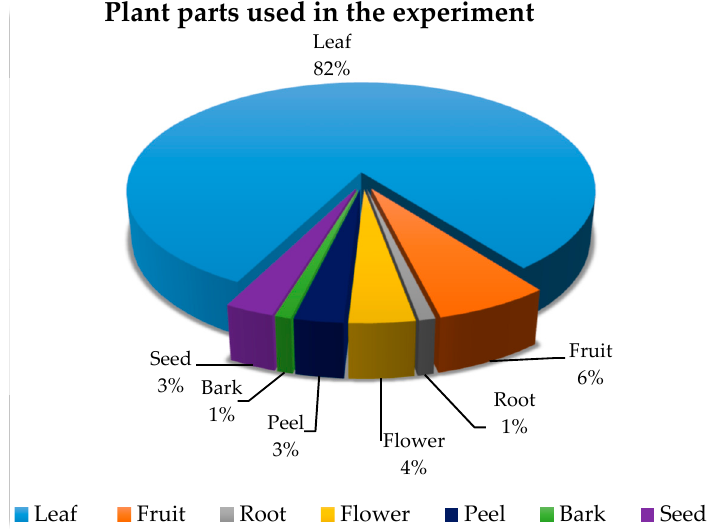
Figure 1. Di ff erent plant parts used for the evaluation of potential volatile allelopathic Figure 1. Different plant parts used for the evaluation of potential volatile allelopathic species.